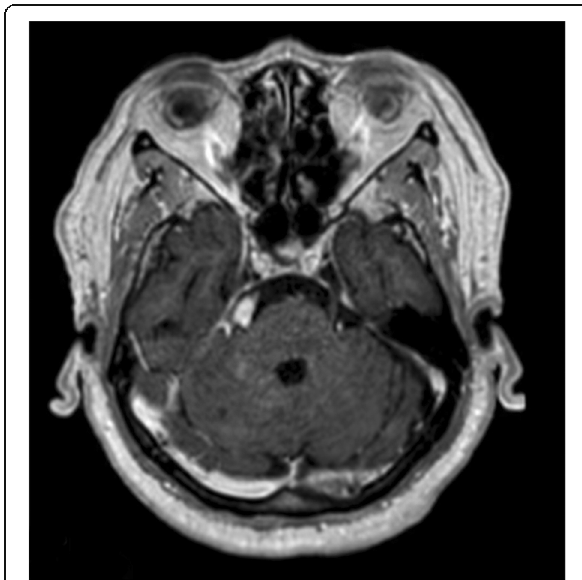
Fig. 1 Posterior fossa MR imaging of the right trigeminal neuralgia patient. The lesion on the right side of the V. nerve (possibly vascular structure) is visible. This structure during surgery has been found to be compatible with the superior cerebellar artery